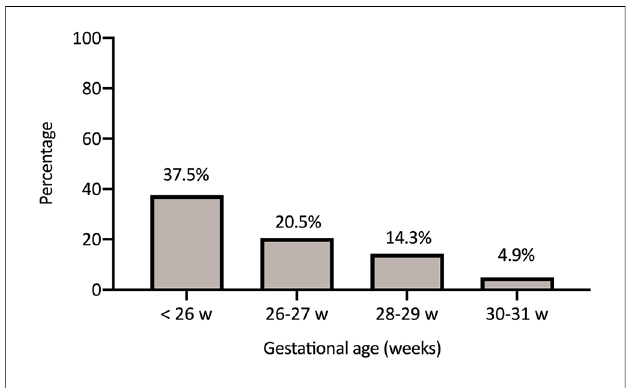
FIGURE 2 Non-invasive ventilation failure rate according to gestational age.